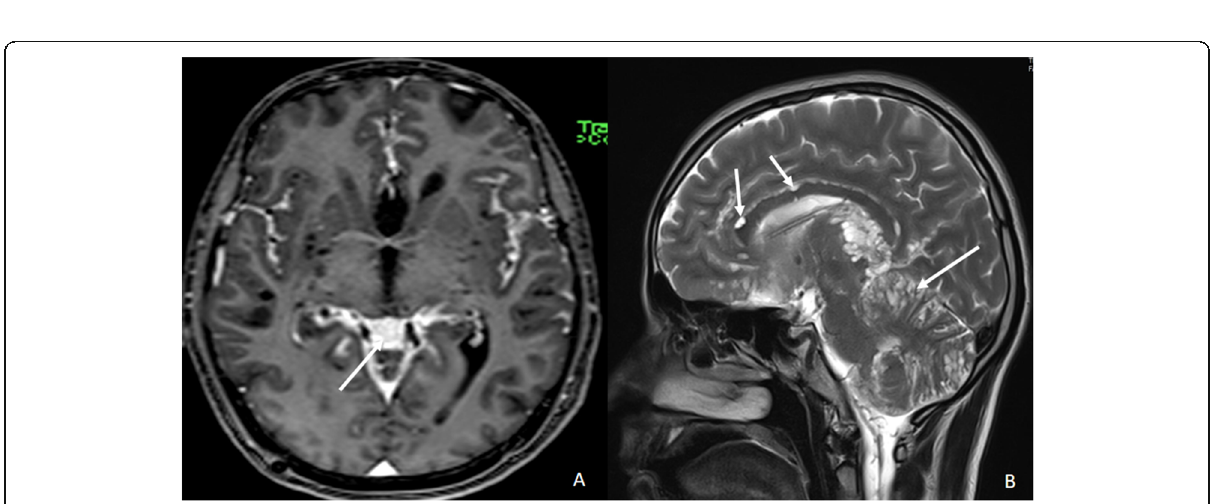
Fig. 3 Follow-up magnetic resonance imaging of the brain at our institute 8 months after the onset of the symptoms. A Post-contrast T1W axial image of the brain at the basal ganglia level shows enhancement along the CSF spaces. The white arrow points towards the enhancement along the CSF spaces in the velum interpositum cistern. B T2W sagittal image of the brain in the mid-sagittal plane shows multiple small cysts of varying sizes along the cerebellar folia and the pial surfaces of the corpus callosum. The white arrows point towards the small cysts along the cerebellar folia and the corpus